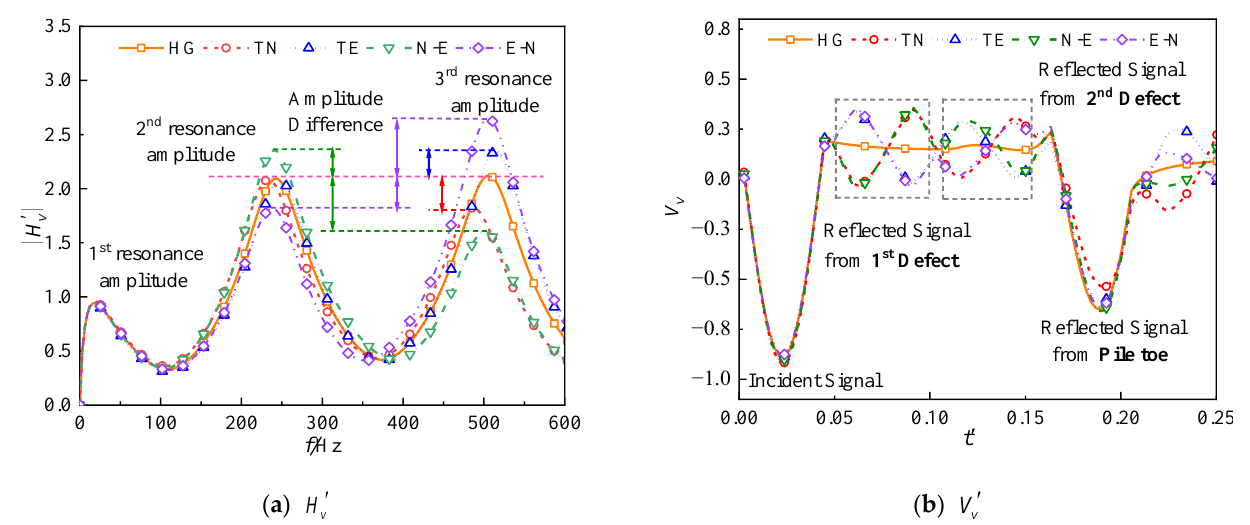
(cid:48) (cid:48) V  . Figure 8. Effect of defect distribution on the pipe pile response. ( a ) H v , ( b ) V v v